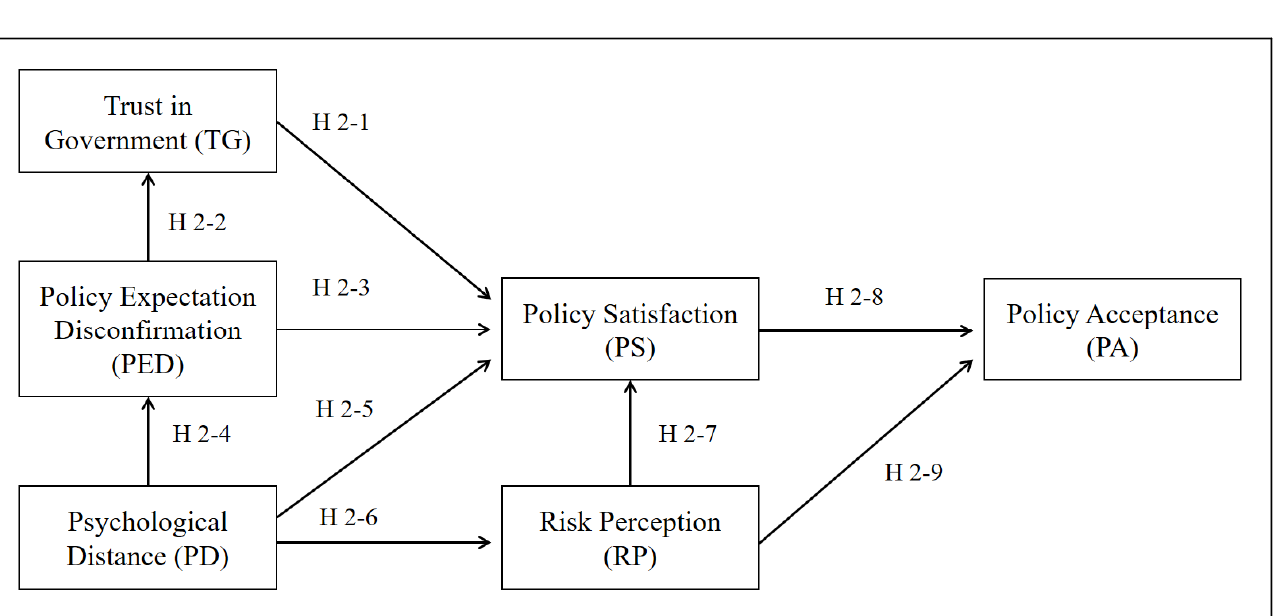
Figure 1. Proposed research model .